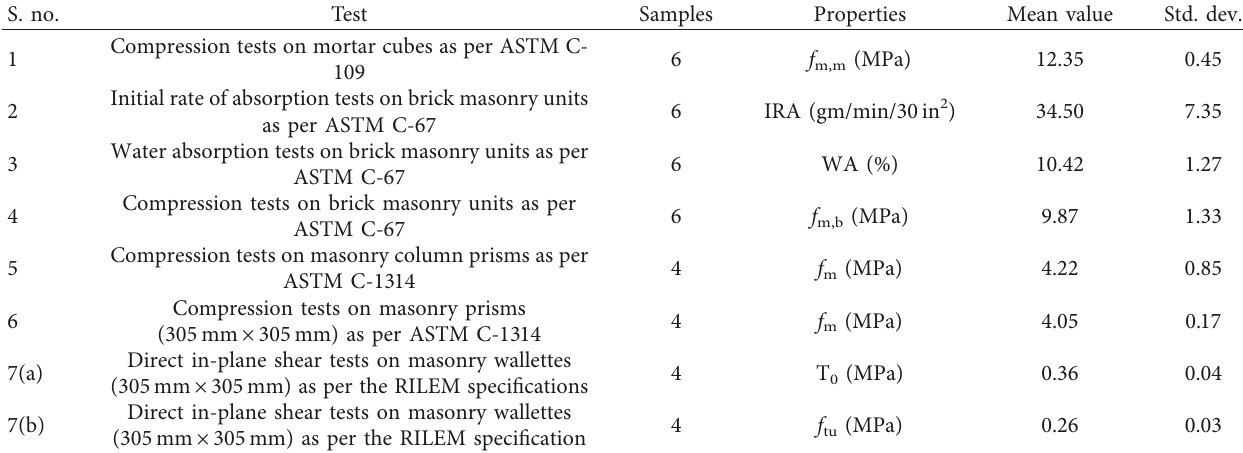
Table 1: Mechanical properties of masonry used for infills in 1:4 reduced-scale models. S. no.